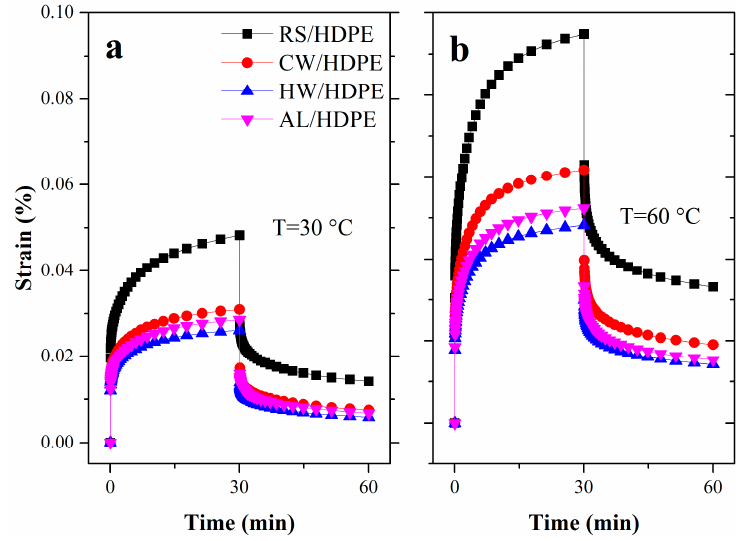
Figure 6. Creep strain of the RS/HDPE, CW/HDPE, HW/HDPE, and AL/HDPE during creep tests at ( a ) 30 °C and ( b ) 60 °C, respectively. ( a ) 30 ◦ C and ( b ) 60 ◦ C,